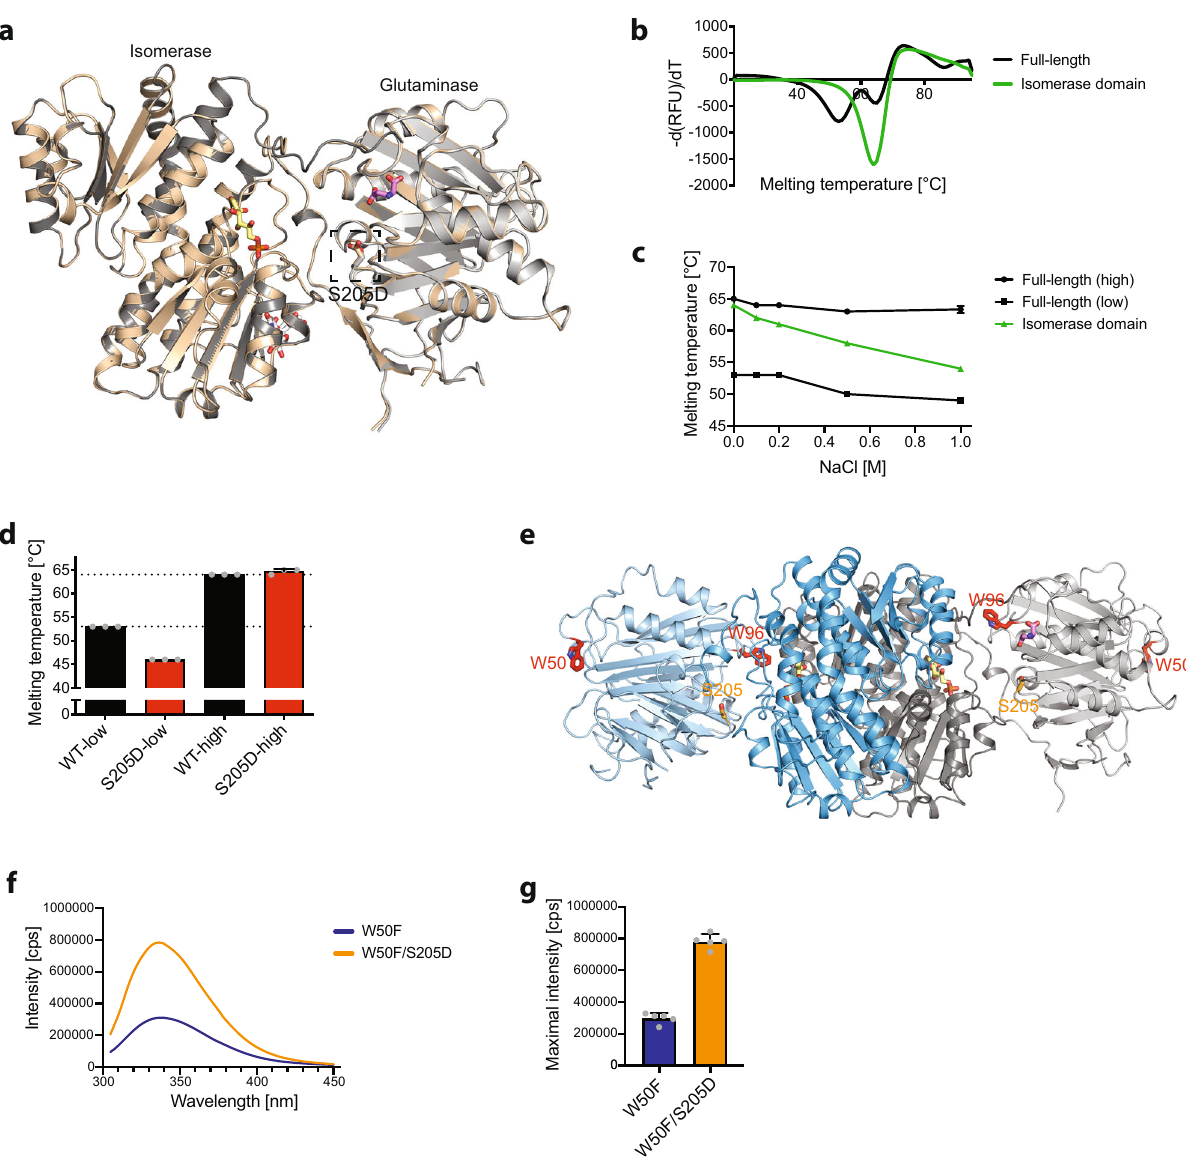
Fig. 5 Altered domain interactions of GFAT-1 after PKA phosphorylation at Ser205. a Position of the phosphorylation site Ser205 in the structure of GFAT-1. Proteins are presented as cartoons. Superposition of wild type GFAT-1 (gray, PDB ID 6R4E) and S205D GFAT-1 (wheat) with an RMSD of 0.77 A ̊ over 1312 main chain residues. Glc6P (yellow sticks), L -Glu (violet sticks), and UDP-GlcNAc (white sticks) are highlighted, as well as the position of S205D (sticks, dashed box). b Representative derivative melting curves of full-length GFAT-1 (black) and the isolated GFAT-1 isomerase domain (green) in standard SEC buffer without NaCl. c Melting temperatures of full-length GFAT-1 (black) and the isolated GFAT-1 isomerase domain (green) GFAT-1 in SEC buffer with rising NaCl concentrations (mean + SD, n = 3). d Melting temperatures of wild type GFAT-1 (black) and GFAT-1 S205D (red) (mean + SD, n = 3). e Positions of tryptophan residues and Ser205 in the structure of wild type GFAT-1. The protein is presented as a cartoon (light gray/dark gray & light blue/marine, PDB ID 6R4E). Glc6P (yellow sticks) and L -Glu (violet sticks) are highlighted, as well as the positions of Trp50, Trp96, and Ser205 (sticks). f Representative fl uorescence emission spectra of W50F (blue) and W50F/S205D (orange) GFAT-1. g Maximal fl uorescence emission of W50F (blue) and W50F/S205D (orange) GFAT-1. (mean + SD, n = 5). Source data are provided as a Source Data fi